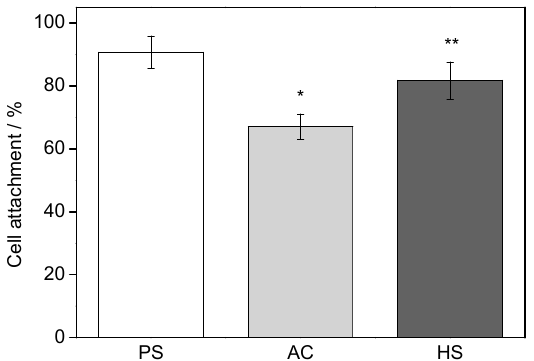
Figure 5. Cell attachment ratio on different specimens 3 h after seeding. * Significantly different compared with PS; ** Significantly different compared with AC.